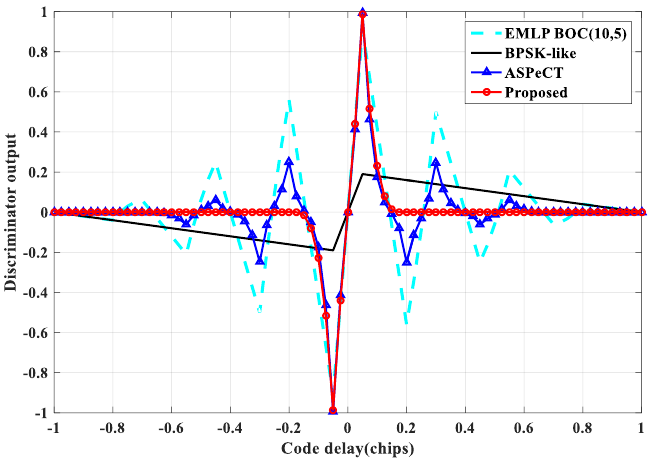
Figure 19. Discriminator output curve of BOC(1, 1).